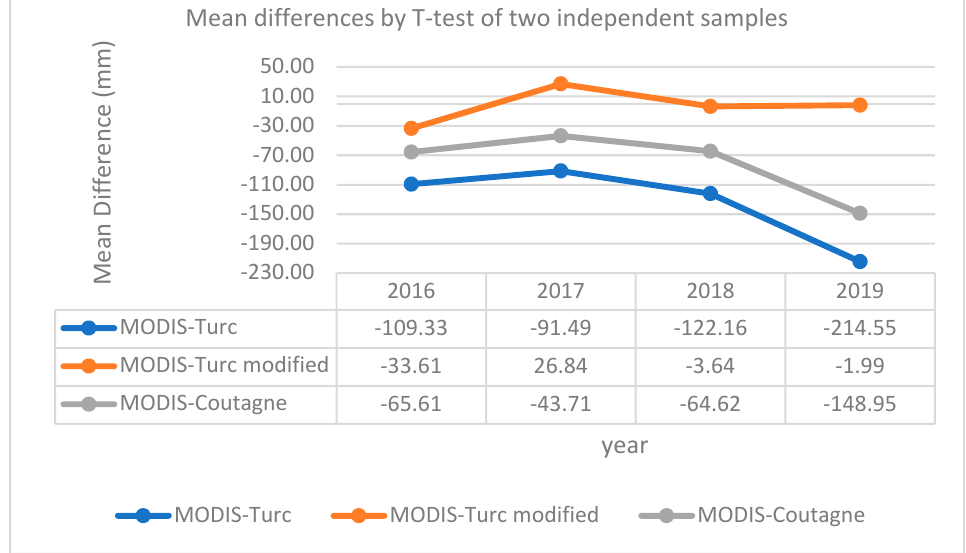
Figure 6. Comparison between mean differences (Student’s t -test) in ETa by empirical methods and MODIS ET for 2016–2019.